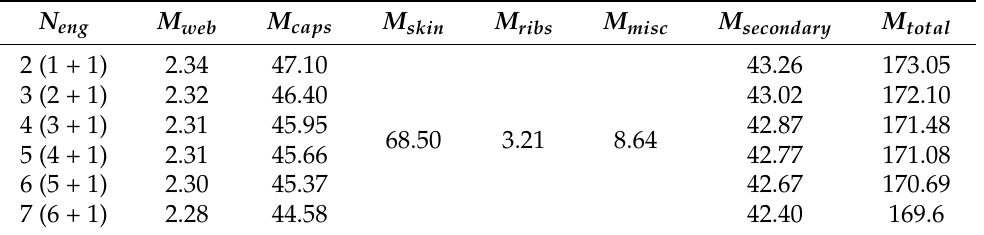
Table 4. Mass breakdown [kg] of the X-57 Maxwell wing for different number of engines on the wing.